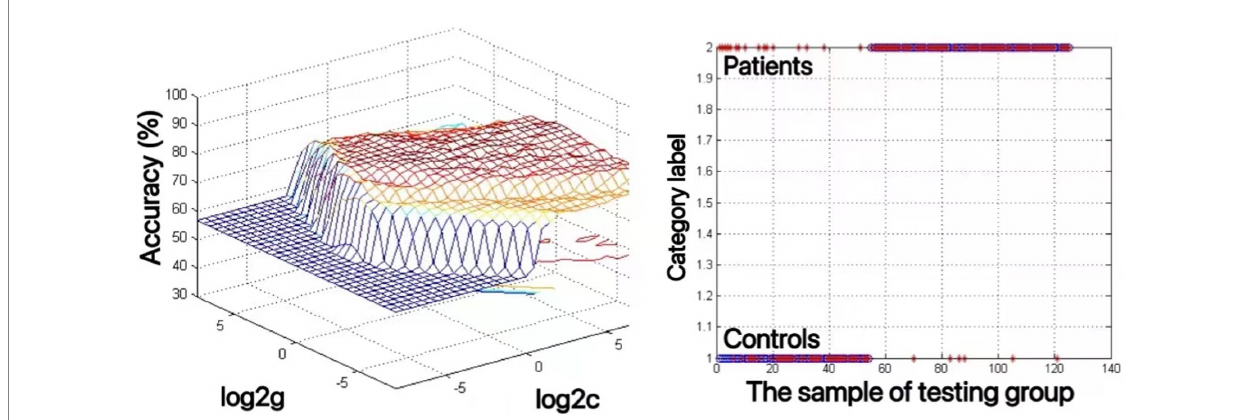
FIGURE 2 The use of decreased ALFF values in the bilateral precuneus to differentiate adolescents with major depressive disorder with suicidal attempts from healthy controls. Visualization of classifications through support vector machine (SVM) techniques using the ALFF values in the bilateral precuneus. Left: SVM parameters selection result of 3D view; Right: Classification map of the ALFF values in the bilateral precuneus.